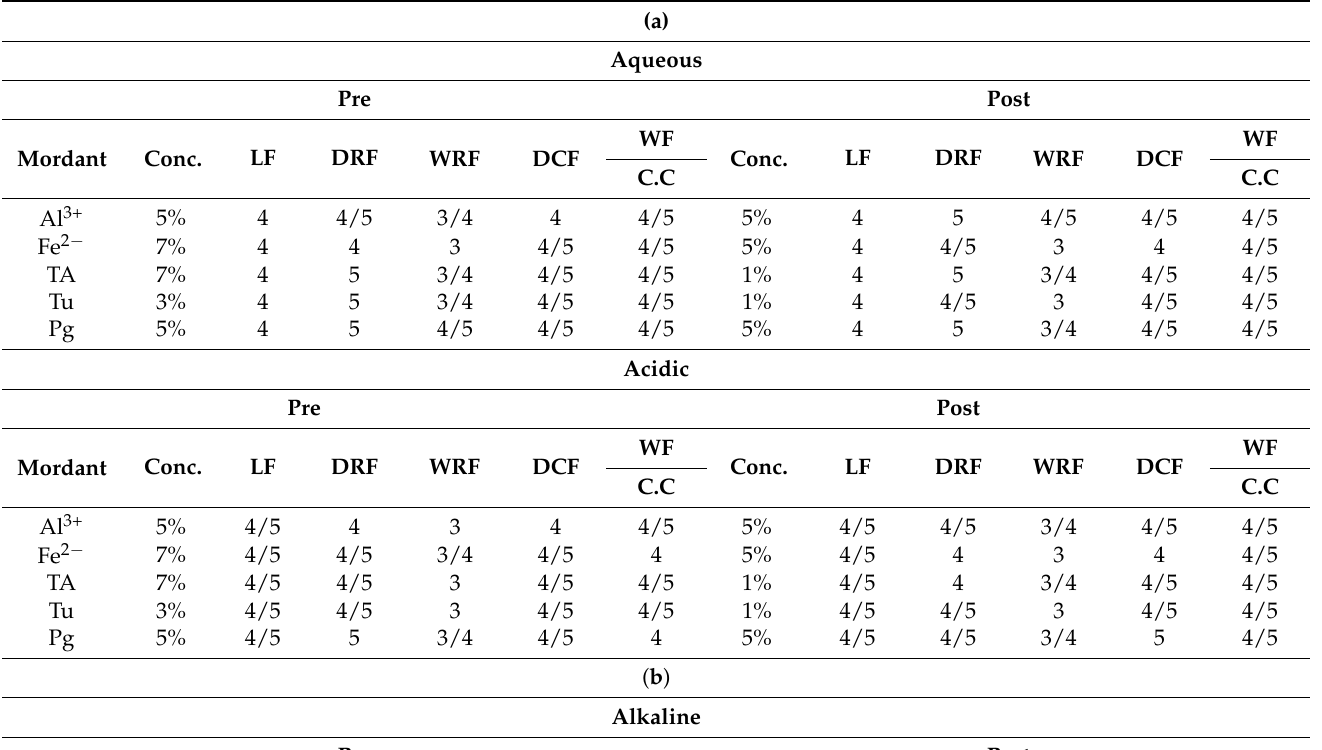
Table 2. ( a ) Fastness properties of wool dyed with ( a ) aqueous and acidic rose extracts & ( b ) alkaline and basified methanol rose extracts before and after